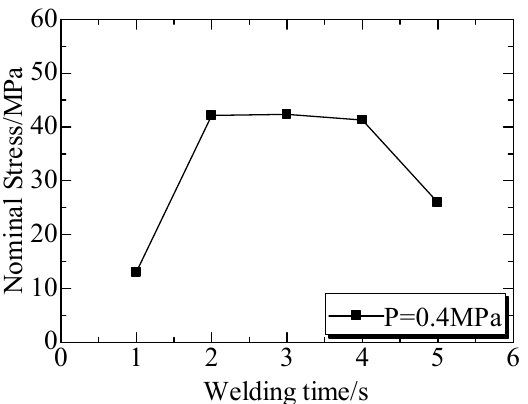
Figure 15. Welded strengths of PLA and POM at different welding times under welding pressure of 0.4 MPa. Adapted from Reference [150].